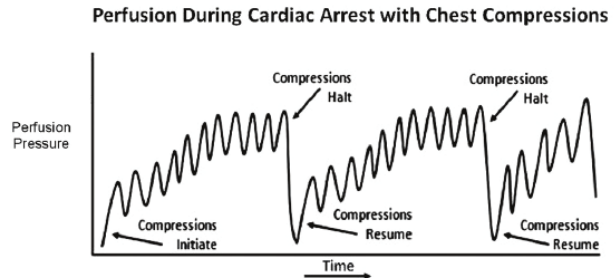
Figure 1: Perfusion pressure gradually increases with the initiation of chest compressions. Interruptions in chest compressions cause a sudden loss of this pressure 17